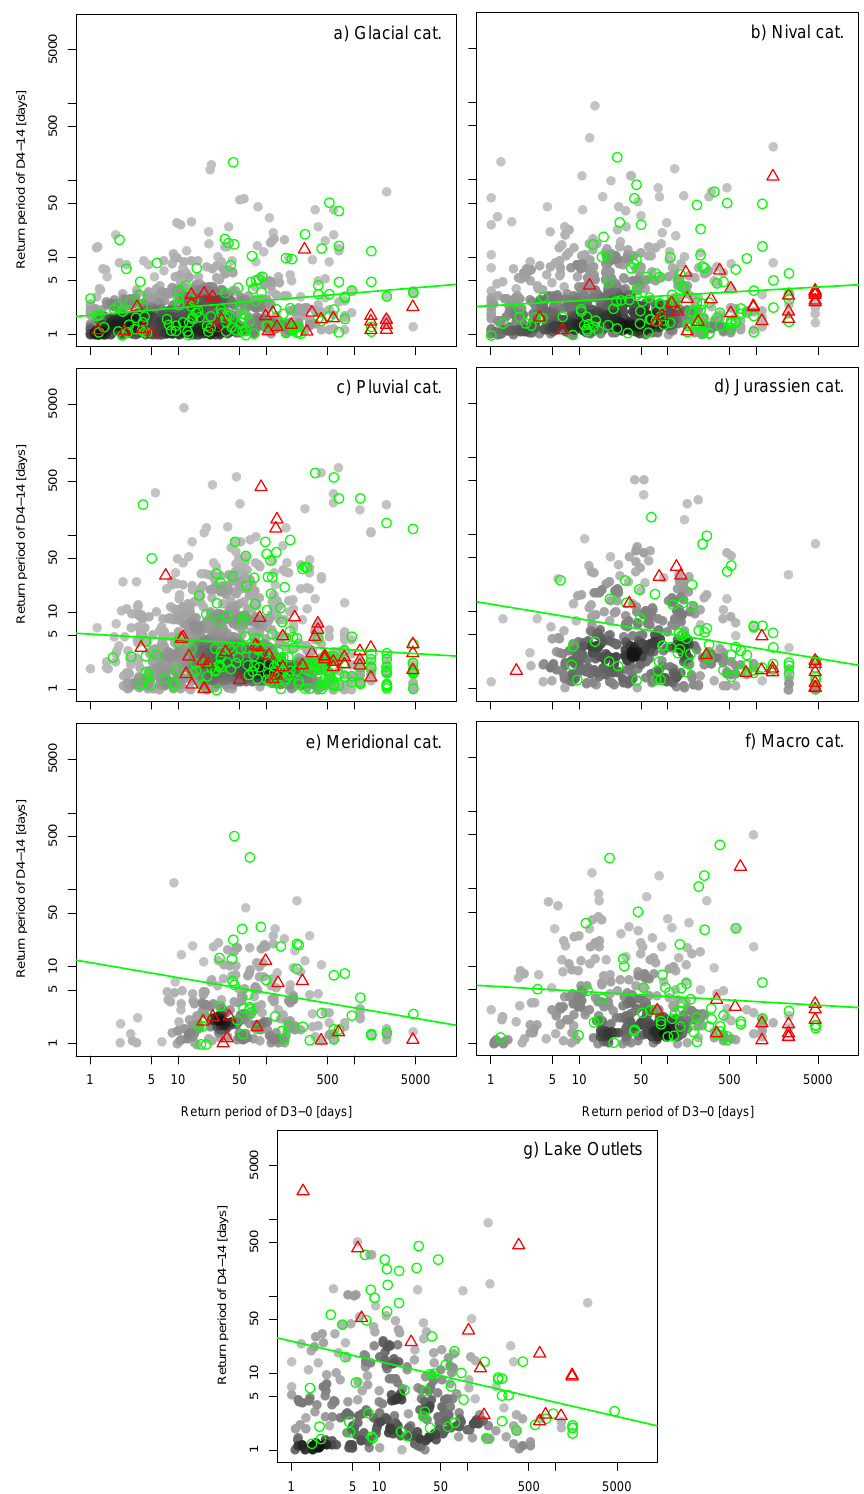
Figure 9. Flood-associated precipitation for different catchment samples: (a) Glacial, (b) Nival, (c) Pluvial, (d) Jurassien, (e) Meridional, (f) Macro and (g) Lake Outlets. For each discharge peak, D0–3 is shown in x and D4–14 in y . Annual floods are shown by gray dots (shadings indicate the density of dots), HQ5s by green dots and HQ20s by red triangles. Green lines show the linear regression of the